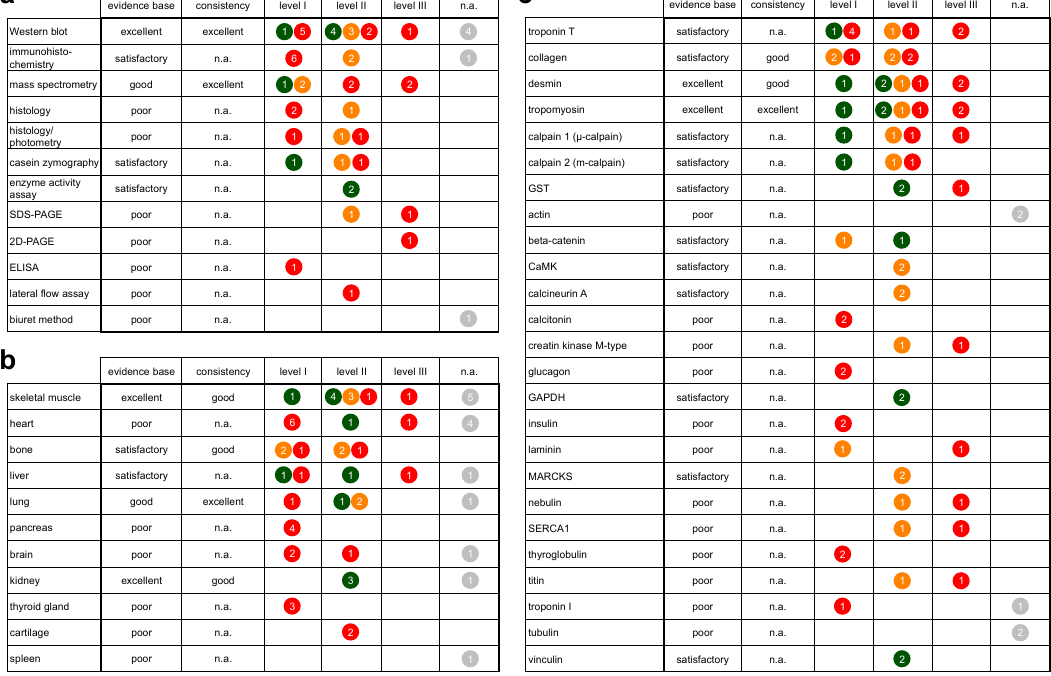
Figure 5. Overview of the body of evidence. Evidence base, consistency and level of evidence are depicted for methods ( a ), tissues ( b ), and proteins ( c ). Studies with low risk of bias are marked in green, those with moderate risk of bias in orange, and those with high risk of bias studies in red. Numbers indicate the amount of corresponding studies. Evidence levels: level I, quantitative studies on human tissue; level II, quantitative animal or human case studies; level III, animal case studies; n.a.: no level applicable (grey) (only referring to studies in review article [25]).